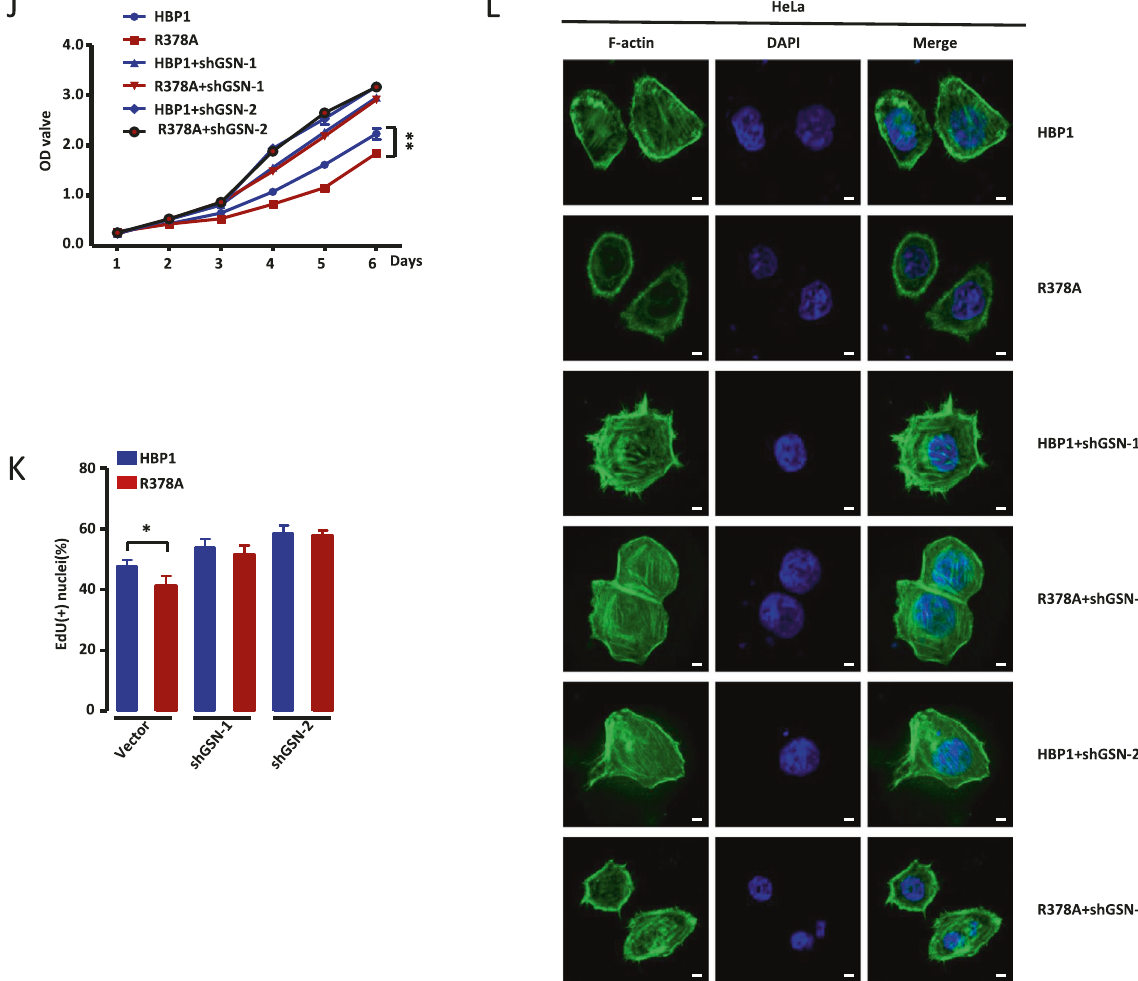
Fig. 6 Methylation of HBP1 promotes actin cytoskeleton remodeling by downregulating GSN. A , C GSN knockdown inhibits cell migration and invasion of HeLa and MGC803 cells. A The protein levels of metastasis-related markers were measured by western blotting in HeLa and MGC803 cells transfected with empty vector, GSNshRNA1 or GSNshRNA2. C Transwell assays were performed to test the migratory and invasive potential of the cells above ( n = 4, one-way ANOVA) ( A ). Scale bar, 200 µm. B , D , E GSN knockdown inhibits cell proliferation in HeLa and MGC803 cells. B The levels of proliferation-related proteins were measured by western blotting in the cells above ( A ). D MTT ( n = 3, one- way ANOVA) and ( E ) EdU incorporation assays were performed to test the ability of cell growth in the cells above ( n = 4, one-way ANOVA) ( A ). F GSN knockdown promotes fi laments formation. F-actin were stained with phalloidin in the cells above ( A ). G Methylation of HBP1 alleviates its inhibition of fi laments formation. HeLa and MGC803 cells were stably overexpressing empty vector, HBP1 or R378A and the levels of F-actin were analyzed by immuno fl uorescence intensity. Scale bar, 5 µm. H – K Methylation of HBP1 alleviates its inhibition of metastasis and growth of HeLa cells through down-regulating GSN expression. H HeLa cells stably expressing HBP1, R378A, HBP1 + shGSN-1, R378A + shGSN-1, HBP1 + shGSN-2, and R378A + shGSN-2 individually, the protein levels of metastasis-related and proliferation-related markers were measured by western blotting. I Transwell assays were performed to test the migratory and invasive potential of the cells above ( n = 4, one-way ANOVA) ( H ). Scale bar, 200 µm. J MTT ( n = 3, one-way ANOVA) and ( K ) EdU incorporation assays were performed to test the ability of cell growth in the cells above ( n = 4, one-way ANOVA) ( H ). L Methylation of HBP1 promotes fi laments formation by downregulating GSN. F-actin were analyzed by immuno fl uorescence intensity with the cells above ( H ). Scale bar, 5 µm. Date were the mean ± SD. * p < 0.05, ** p <